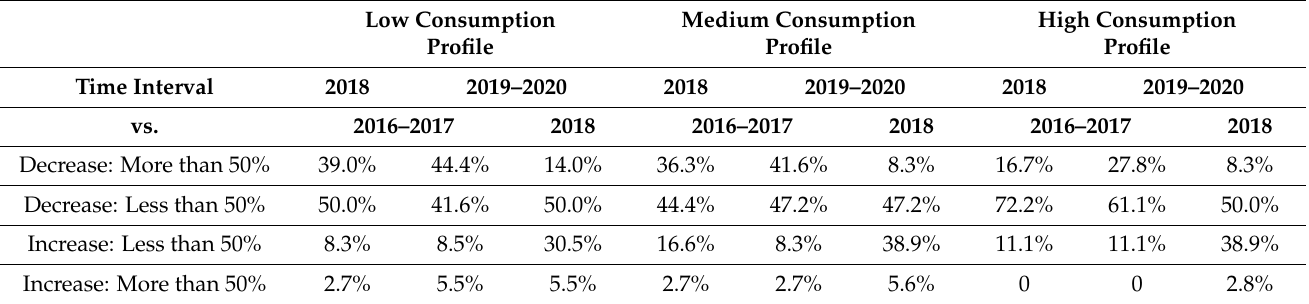
Table 7. Variations in electricity consumption: pairwise comparison between different time intervals. Figure 5. Histogram plots of the distribution in relative changes in electricity consumption com- pared to the first time interval (i.e., 2016 – 2017) in per unit values: ( a ) low consumption profile; ( b ) medium consumption profile; ( c ) high consumption profile.